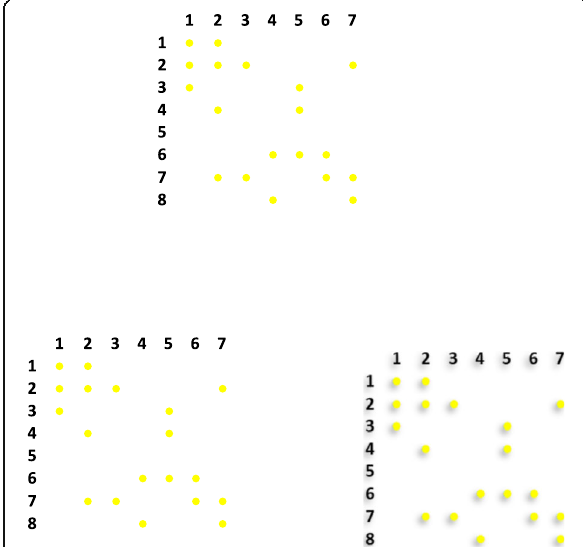
Fig. 7 The simulated CMYK mode of the coded dot matrix model in a yellow color of color laser Ricoh ® SP C 420 DN